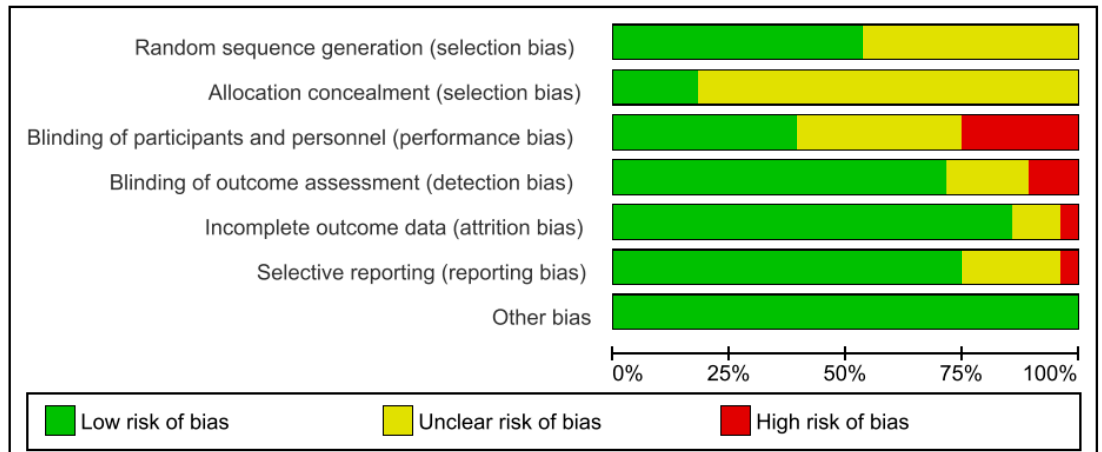
Figure 5. Risk of bias graph: Review authors’ judgements about each risk of bias item presented as percentages across all included studies.